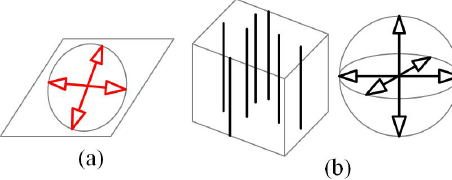
Figure 3. Symmetrical constraint spaces. (a) The first type. (b) The second type. (c) The third